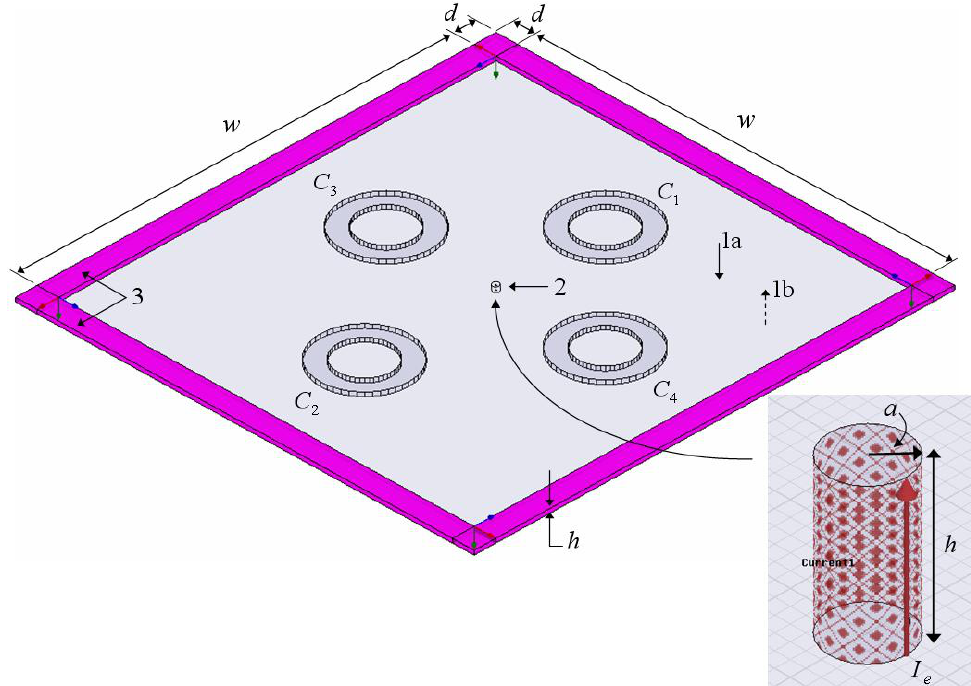
Figure 2. The HFSS model of the 4-cylinder structure. 1: Perfectly conducting top (1a) and bottom (1b) plates; 2: Electric current tube (enlarged in the inset of the figure); 3: Uniform perfect matching layers. The figure is not to scale. See the main text for further